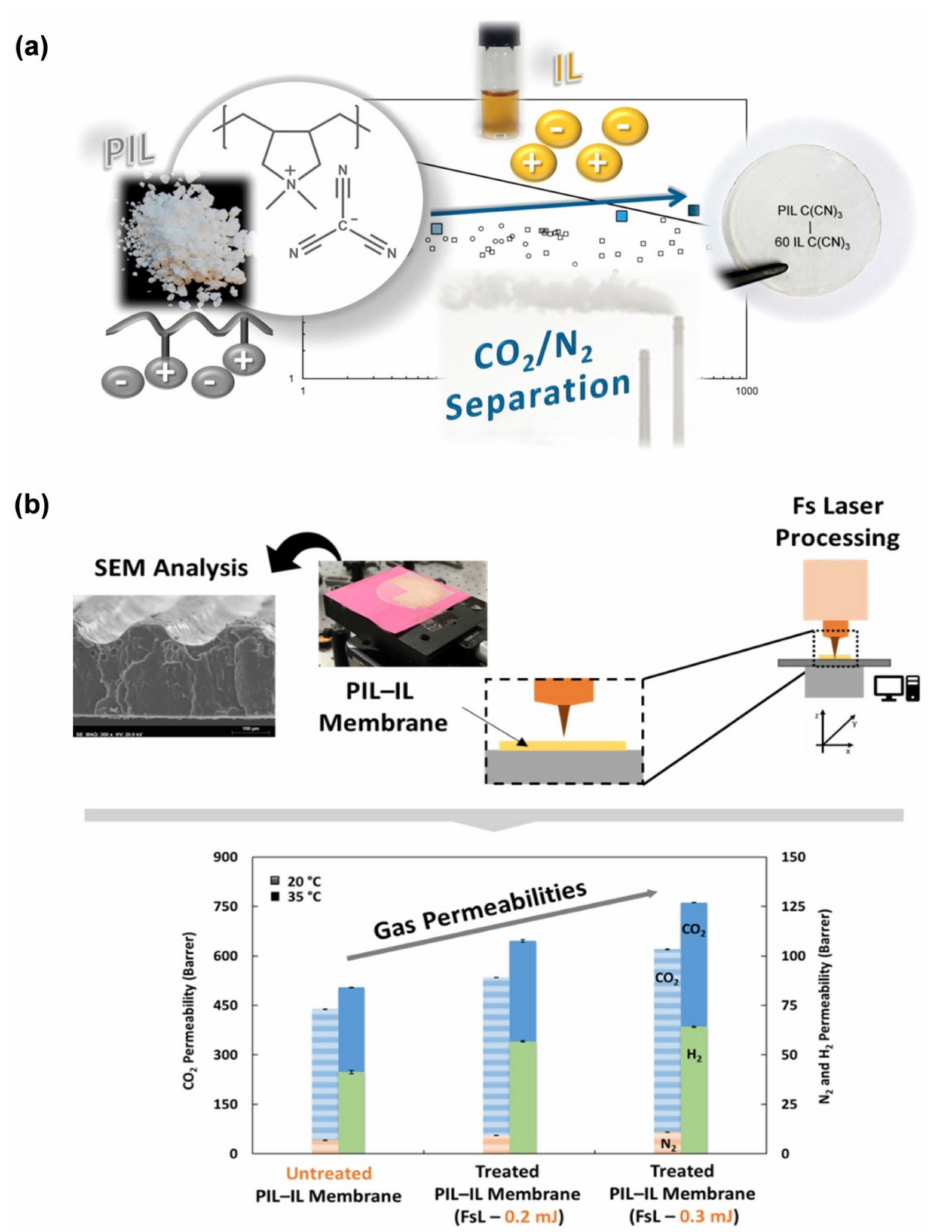
Figure 7. ( a ) CO 2 /N 2 separation performance of PIL/IL membranes containing cyano-functionalised anions. Reprinted with permission from Tom é et al. [204] Copyright 2015, Elsevier. ( b ) Schematic illustration of the creation of microchannels on the surface of PIL/IL membranes by laser ablation using femtosecond laser radiation (top) and respective effect on permeability towards CO 2 , N 2 , and H 2 (bottom). Reprinted with permission from Gouveia et al. [208]. Copyright 2022,